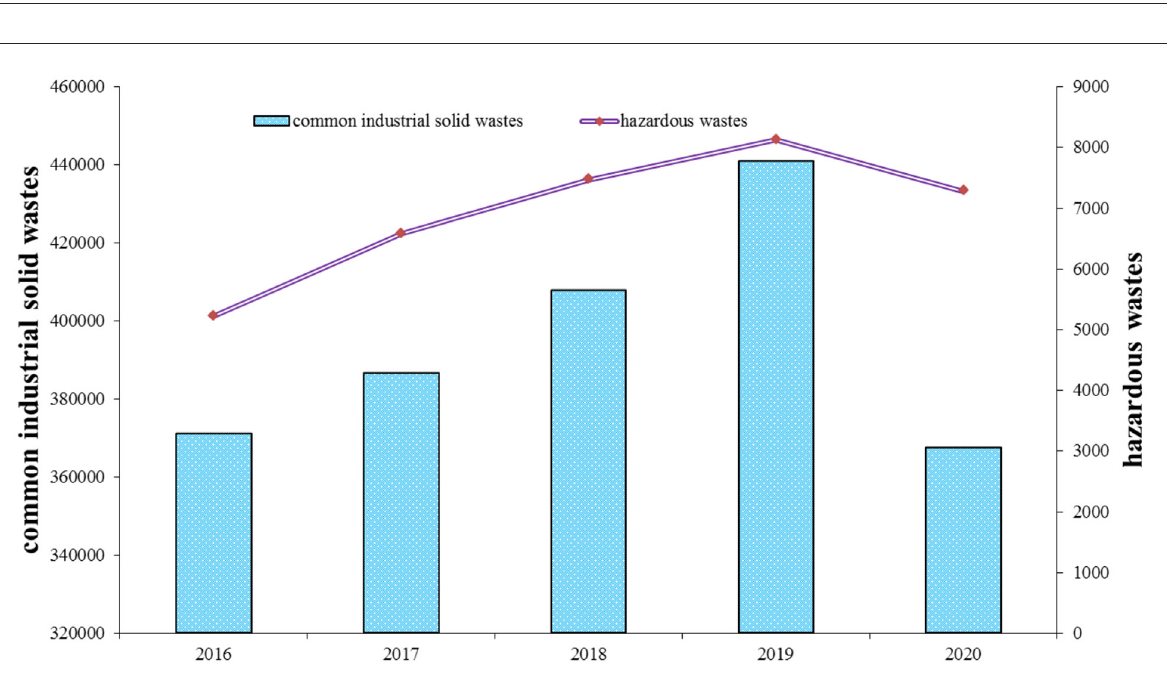
in this sector and the environmental regulations (especially those that entail controlling pollutant emissions) imposed by policy